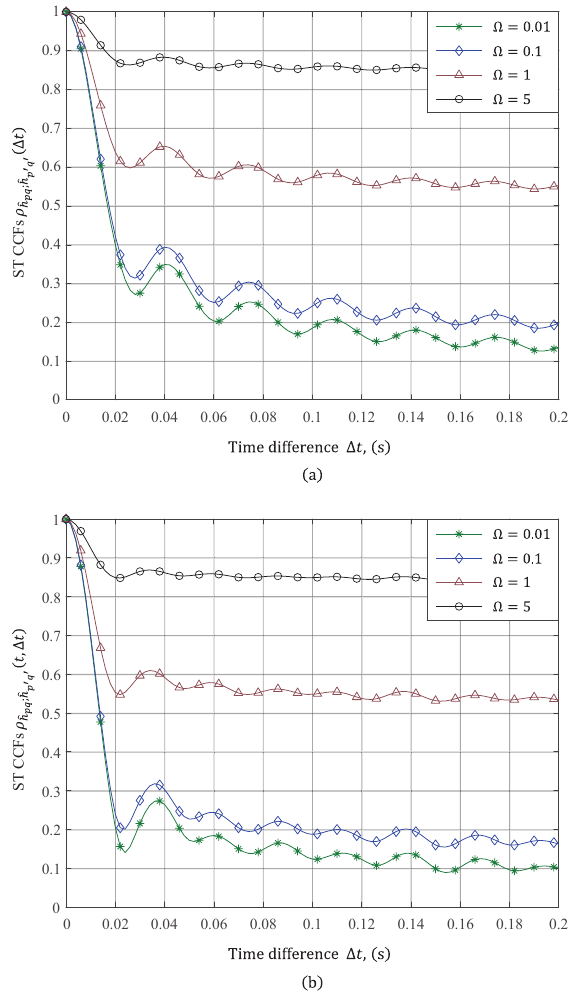
( t , ∆ t ) of MIMO V2V channel models for different Rician factors Figure 9. Estimated ST CCFs ρ ˆ h pq ; ˆ h p (cid:48) q (cid:48) Ω when t = 2 s, v T = v R = 10 m/s, ϕ T = π , and ϕ R = 0. ( a ) WSSUS channel model; ( b ) non-WSSUS channel